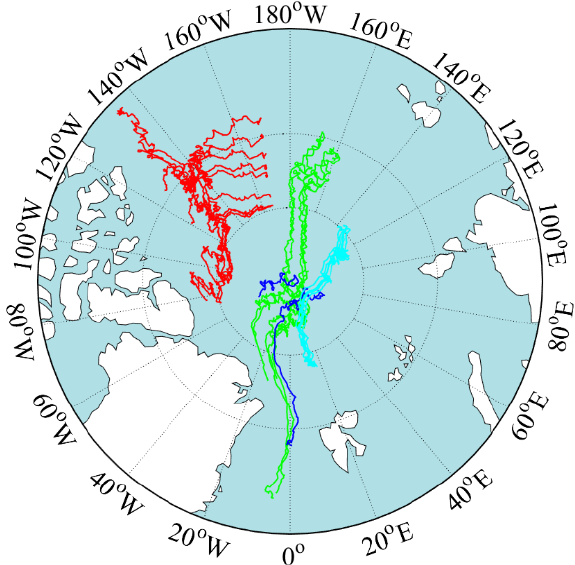
Figure 5. Trajectories of SIMBA buoys deployed in the Arctic in the period 2018–2019. Red: Chinese National Arctic Research Ex- pedition (CHINARE) (10 buoys), green: Nansen and Amundsen Basins Observational System (NABOS) (5 buoys), dark blue: CAA- TEX (2 buoys), and light blue: MOSAIC (15 buoys). SIMBA is a thermistor string-based ice mass balance (IMB) buoy. It measures high-resolution (2cm) vertical environment temperature (ET) pro- files (four times a day) through the air–snow–sea ice–ocean column. The heating temperature (HT) measured by the thermistor string once per day is based on the use of a small identical heater on each sensor. The ET and HT data are used to derive snow depth and ice thickness. SIMBA uses the GPS module to track the buoy location. The Iridium satellite is used for data transmission. A to- tal 15 SIMBA buoys were deployed in the Arctic Ocean during the CHINARE 2018 and NABOS 2018 field expeditions in late autumn. In 2019 17 SIMBA buoys were deployed during the CAATEX (2) and MOSAIC expeditions (15, leg